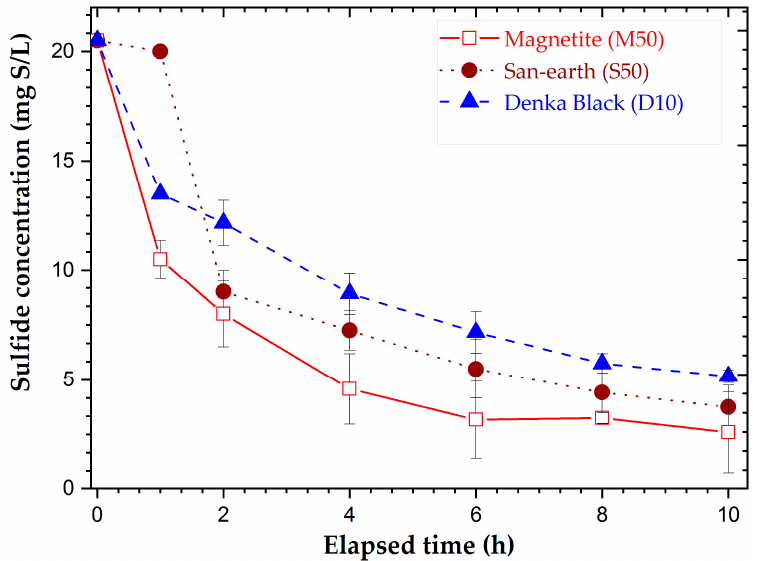
Figure 5. Effect of the sulfide adsorption with time for three different